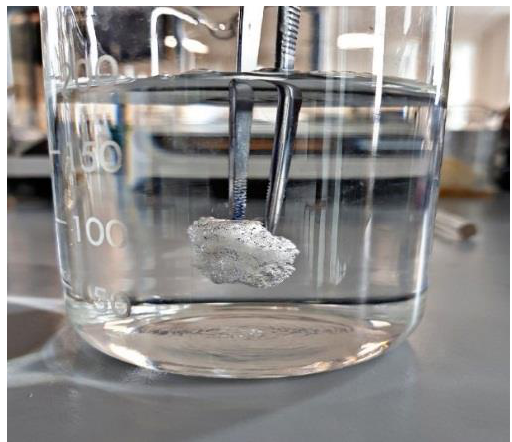
Figure 3. Hydrophobicity test showing air bubbles trapped on the surface of a functionalised cigarette filter.